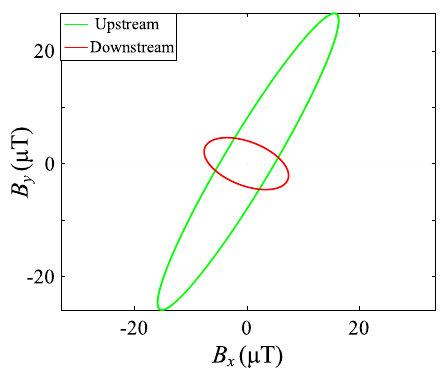
Fig. 20 Magnetic field ellipse in the case of load side